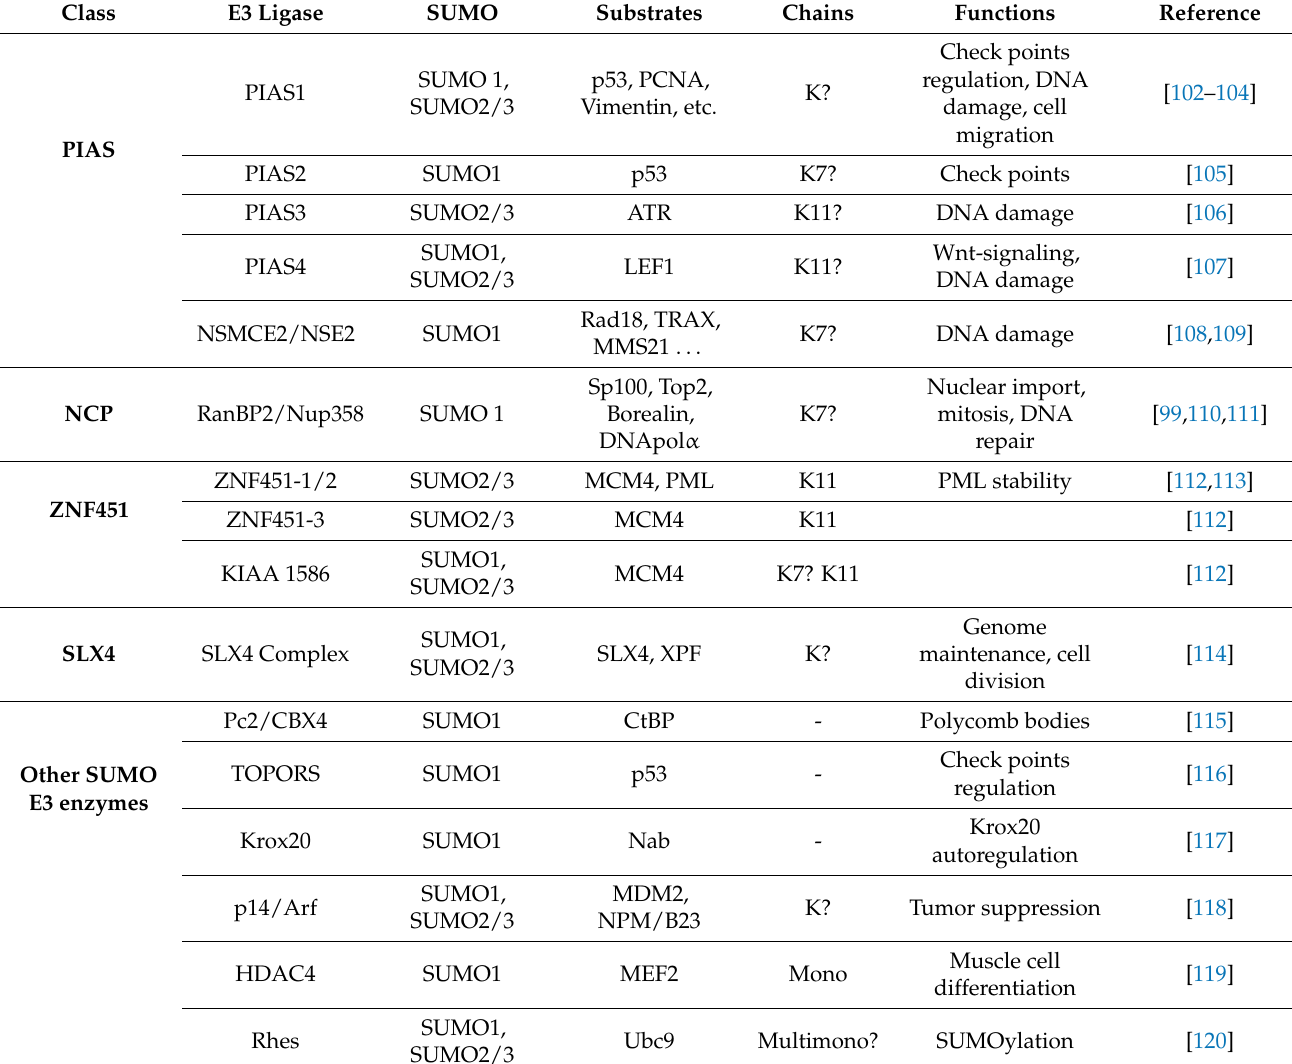
Table 2. SUMO E3